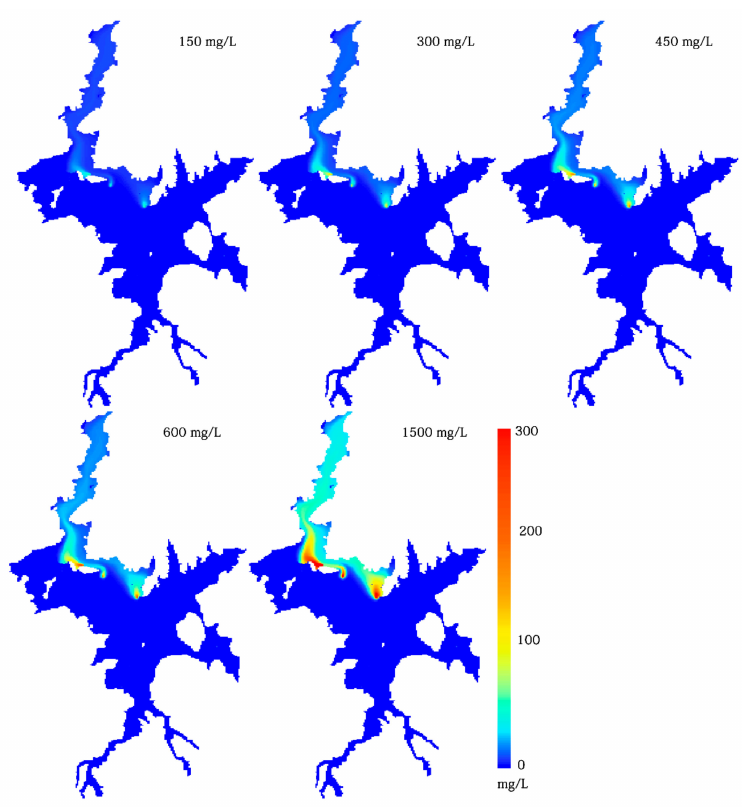
Figure 10. The spatial distribution the maximum increment of the SSC under di ff erent dredging